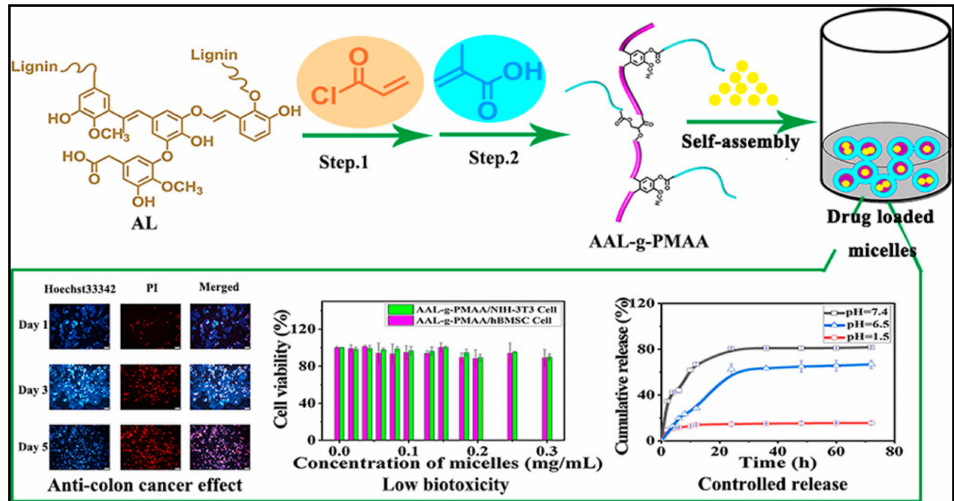
Figure 9. Structure of AAL-g-PMAA and self-assembly into nanomicelles and ibuprofen (IBU) can be loaded in the Core (up). Drug release profile, cytotoxicity study and bioimaging results (down). Reprinted with permission from [169]. Copyright © 2020, American Chemical